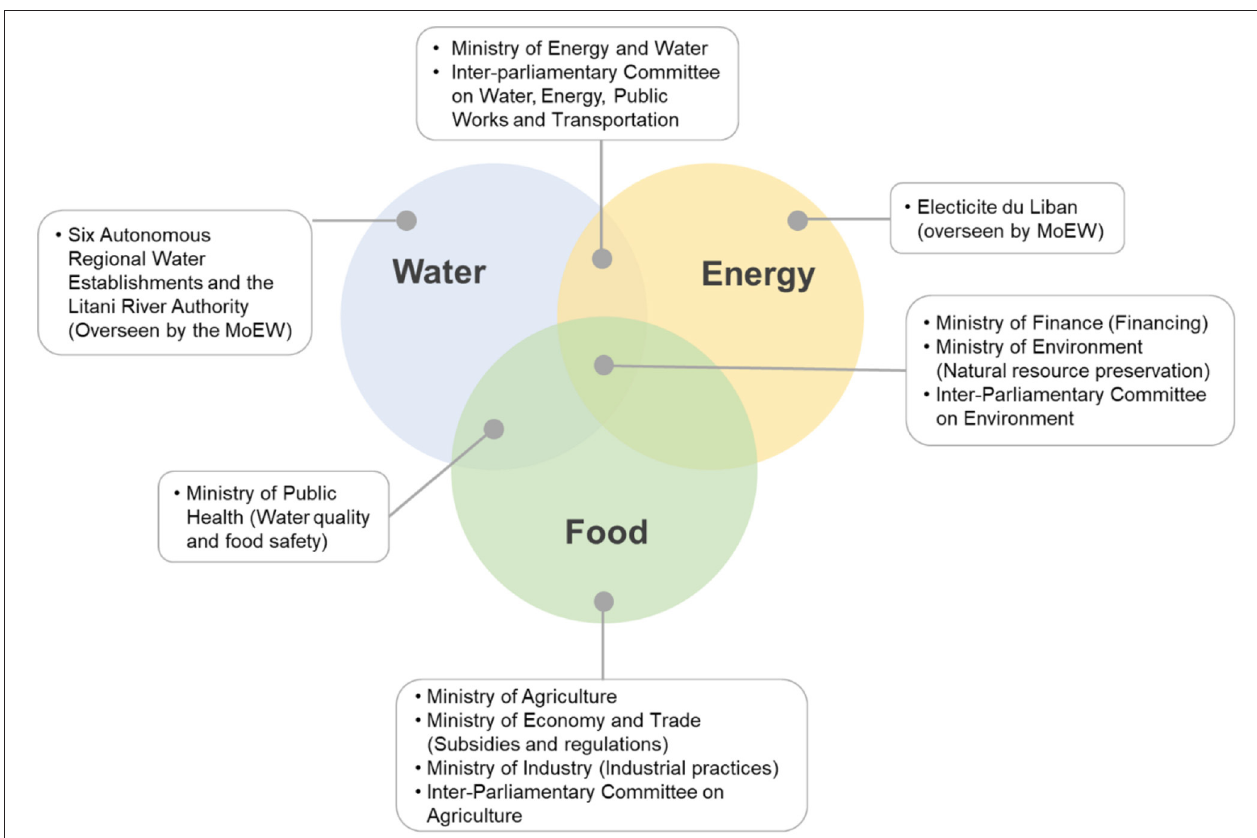
FIGURE 4 | Summary of key actors across the interconnected resource